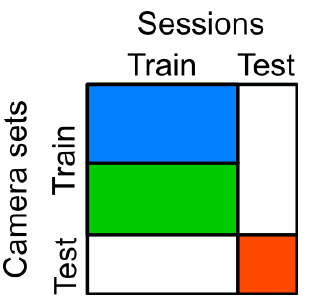
Figure 3. Separation of the training and test sets for the subject sessions and camera sets (blue: reduced training camera set; blue and green: full training camera set; red: test camera set; white: unused